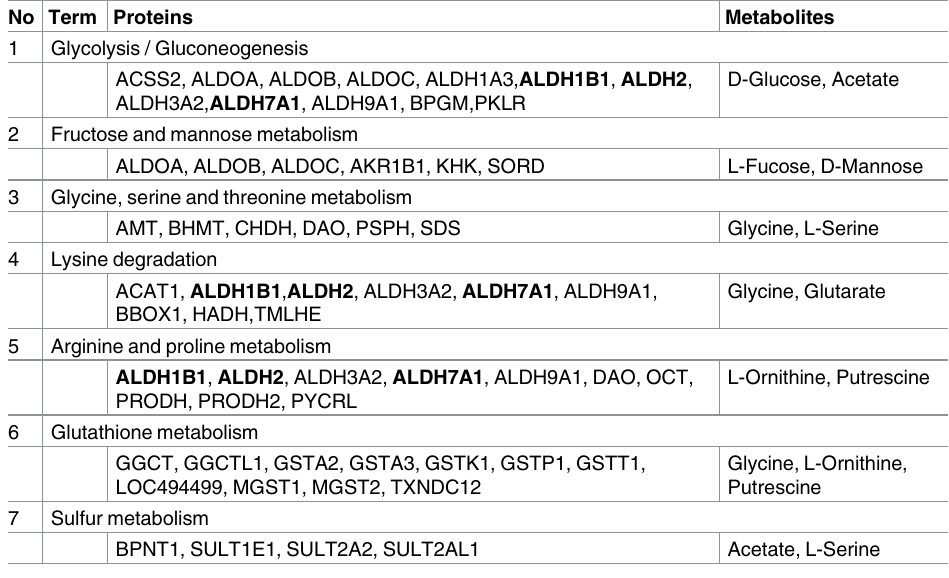
Table 3. Significantly altered pathways with differentially expressedproteins and